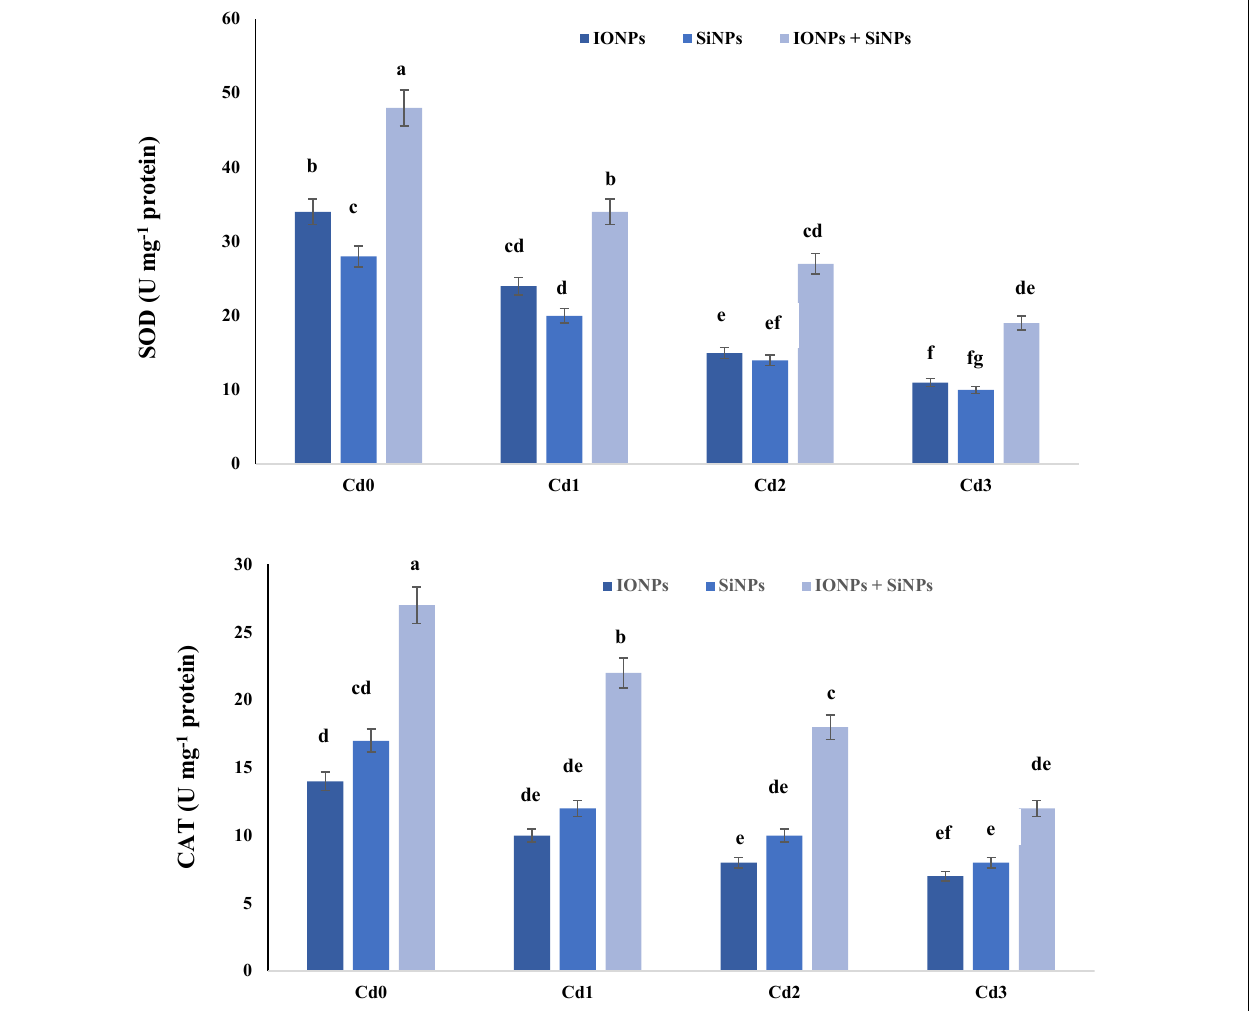
FIGURE 5 | Effect of IONPs and SiNPs on SOD and CAT activity of P. vulgaris grown in different concentrations of Cd. Here IONPs, SiNPs, Cd0, Cd1, Cd2, and Cd3 indicate iron oxide nanoparticles, silicon nanoparticles, 0 mM CdCl 2 , 1 mM CdCl 2 , 1.5 mM CdCl 2 , and 2 mM CdCl 2 . Different letters indicate significant difference among the treatments ( P ≤